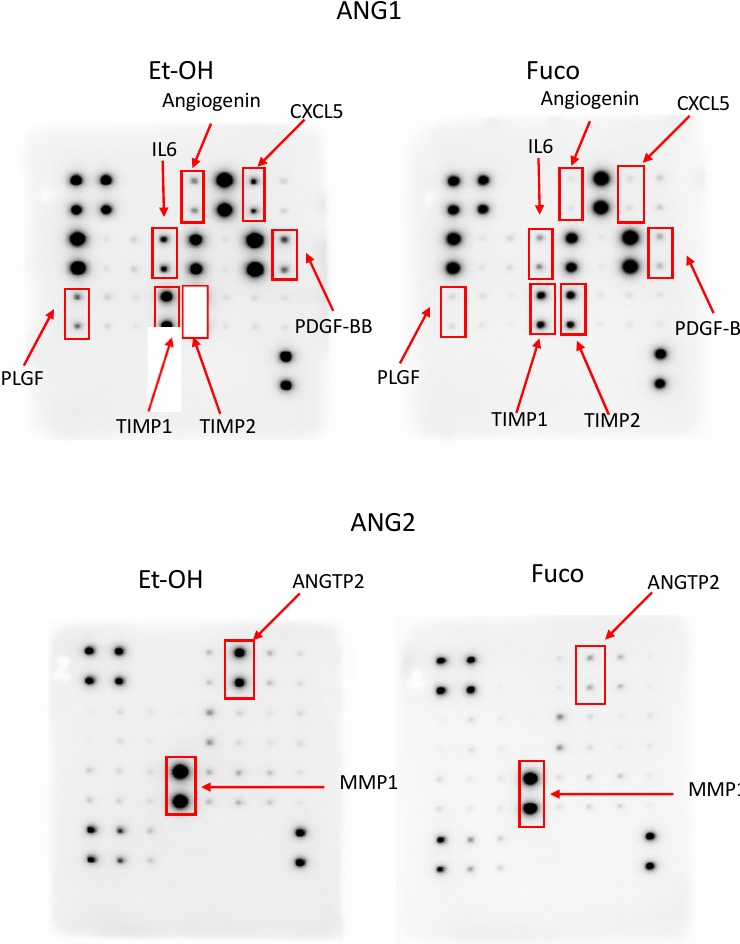
Figure 11. Protein expression profiling in endothelial cells treated with fucoxanthin. Antibody arrays representing cytokine expression in HUVECs stimulated with TNF α (10 ng/mL) after treatment with Fuco (20 µg/mL). EtOH was used as vehicle control ( n = 2). ANG1 and ANG2: Human Angiogenesis Array C1 and C2, respectively.